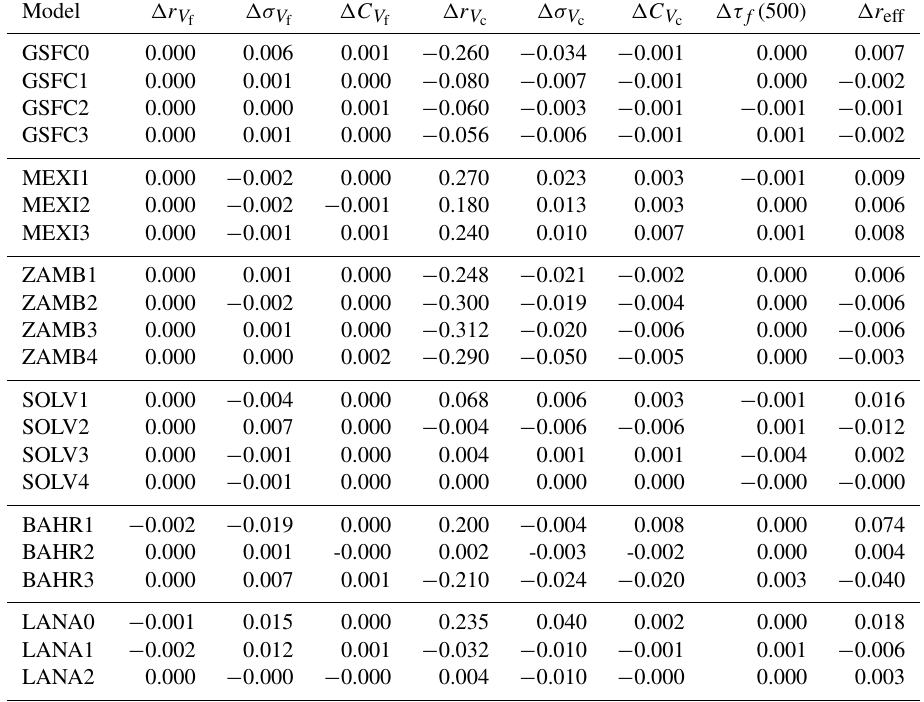
Table 3. Differences obtained from the self-consistency test on GRASP-AOD code obtained by comparing parameters in Tables 1 and 2. The first six columns provide parameters that represent the bimodal log-normal size distributions (volume median radius ( r V ometric standard deviation ( σ V and σ V ) and volume concentration ( C V , C V [µm 3 µm − 2 ])). The following columns contain two secondary c c f f products derived from the GRASP-AOD inversions and the corresponding reference values: fine-mode aerosol optical depth at 500nm ( τ f ( 500 ) ) and the effective radius ( r eff